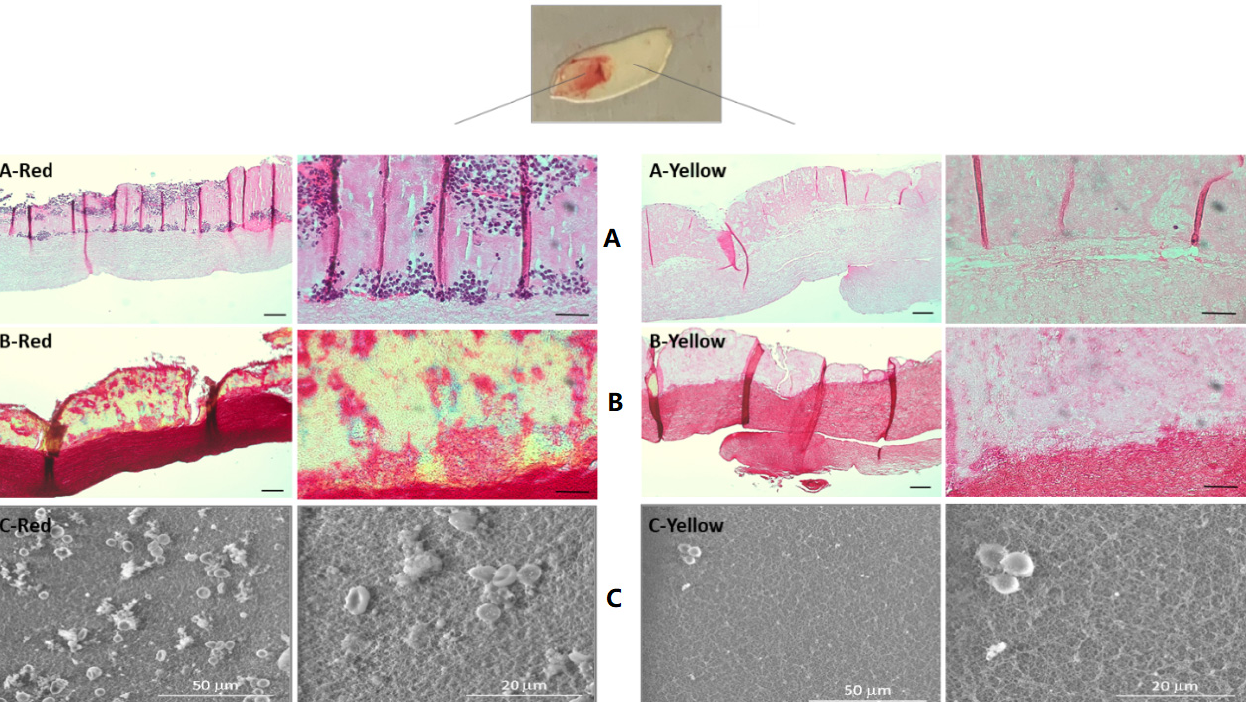
Figure 1. Microscopic appearance of the L-PRF membrane with its distinct portions. Images on the left side correspond to the red portion, while images on the right correspond to the yellow portion. ( A ) Haematoxylin and eosin (H&E) staining: fibers were stained in pink and the cellular nuclei were stained in purple. ( B ) Masson’s trichrome staining, fibers and erythrocytes were stained in bright red and nuclei in black. Scale bar = 100 and 50 µm respectively. ( C ) SEM images of the L-PRF membrane. High magnification images showed the porous morphology of the fibrin strands network. The red portion of the membrane contains a high number of erythrocytes and platelets. Attached platelets showed abundant thin cytoplasm extensions suggesting an activated state.